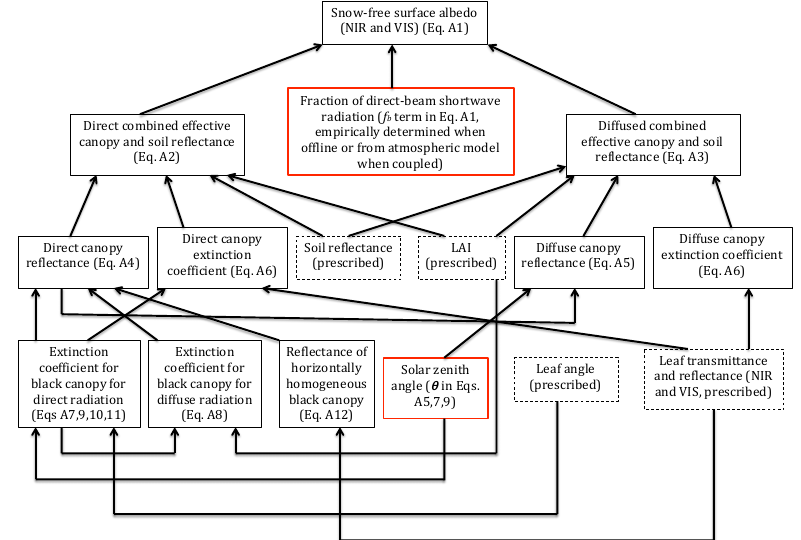
Figure 1. Schematic illustration of snow-free surface albedo parameterisation in CABLE. Boxes with dashed lines represent user-defined input parameters to the model. The boxes with solid black lines represent the equations described in Appendix A and the boxes in solid red lines represent terms used in the